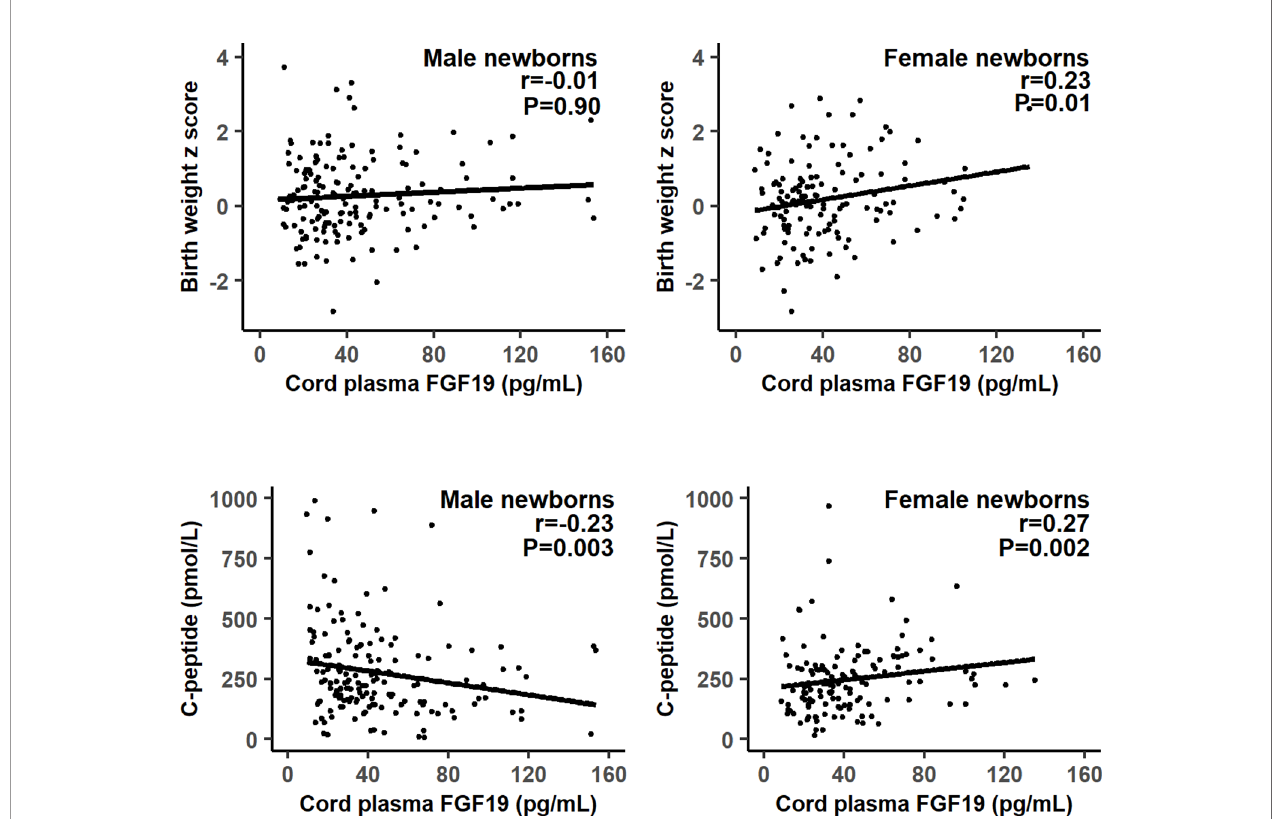
FIGURE 1 | Scatter plots illustrating the differential correlations between cord plasma fi broblast growth factor 19 (FGF19) and fetal growth (birth weight z score) or C-peptide in males and females.